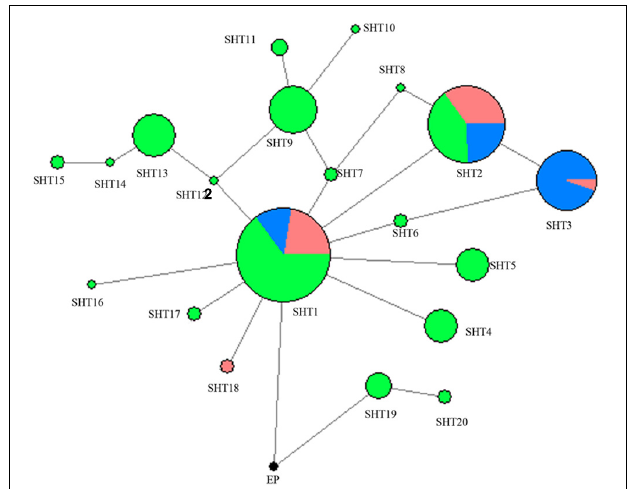
FIGURE 1 | MJN network was constructed using 14 ECAY segregating sites. Circle size was proportional to the haplotype frequency. Blue indicates introduced breeds; green, southern horses; red, northern horses; and black, Przewalski’s horse.